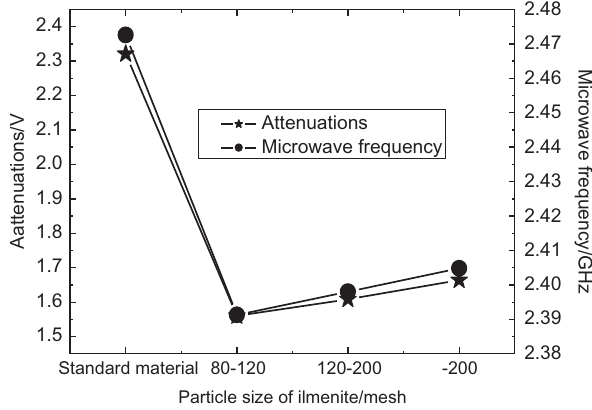
Figure 3: Effect of ilmenite concentrate size on the attenuation and microwave frequency of oxidation products (oxidation temperature is 700°C and oxidation time is 30 min) (Standard material: TiO 2 with its particle size of – 40 + 80